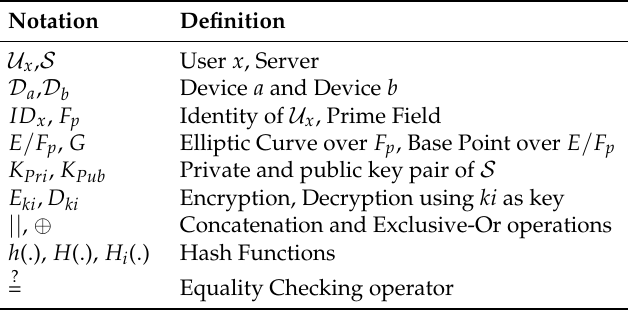
Table 1. Notation